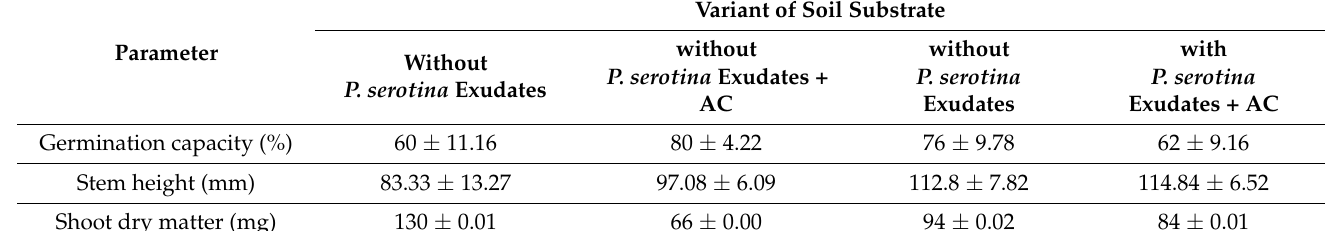
Table 4. Effect of different variants of soil substrate on germination and seedling growth of Fagopyrum esculentum in pots. Data are mean ± SE, n = 10.